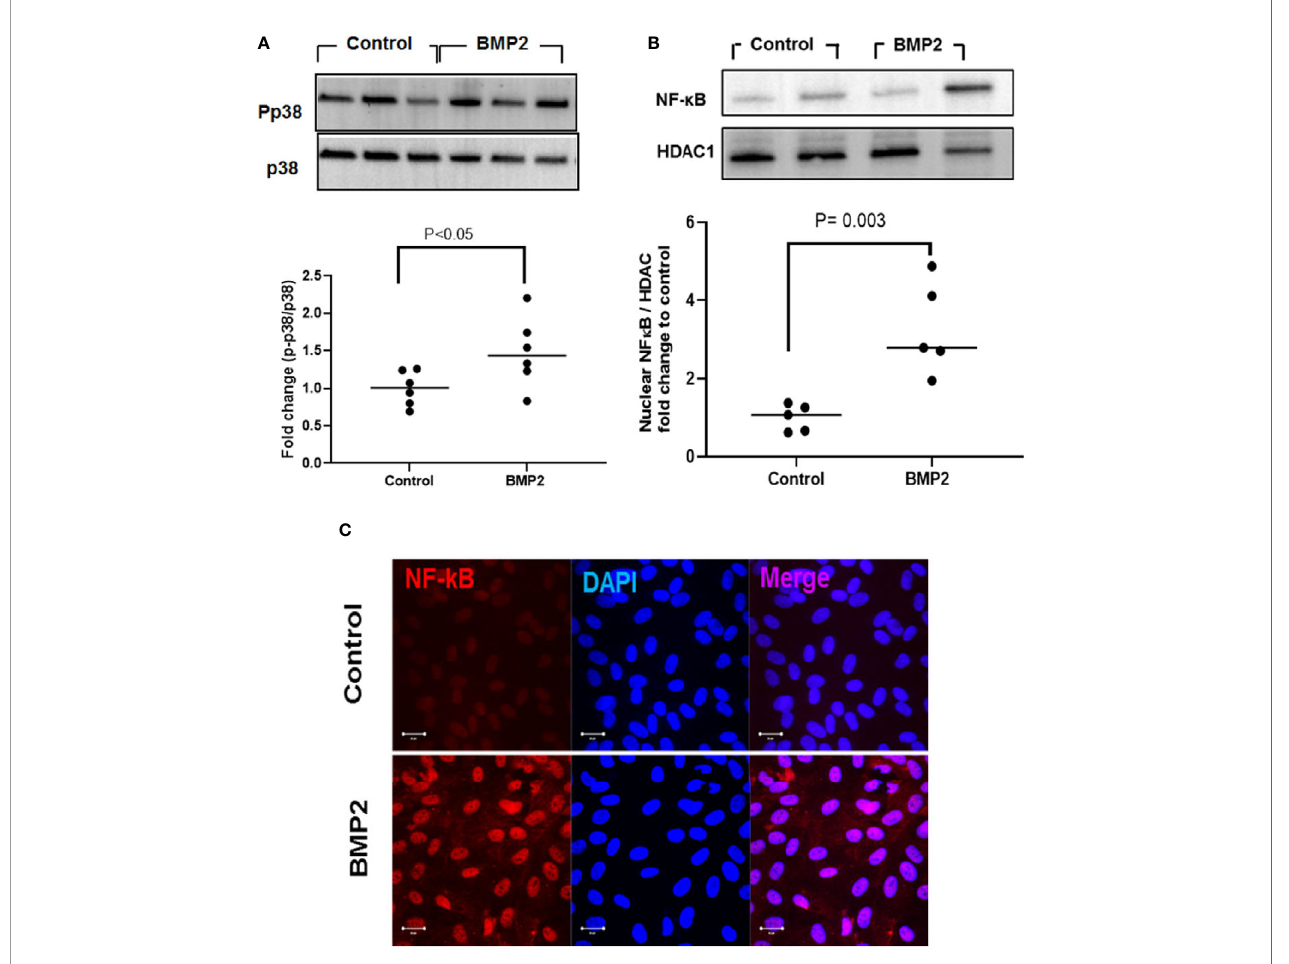
FIGURE 3 | Western blot analysis of the effect of rhBMP2 on p38 and NF k B. Unpaired t-test was used to compare the effect of rhBMP2 on p-p38 and nuclear NF k B compared to control. Densitometry analysis showing signi fi cant increase in the levels of p-p38 and the nuclear NF k B in human retinal endothelial cells (HRECs) compared to the control ( A , B respectively). IF (C) also showing marked increase in the nuclear (blue) immunoreactivity of NF k B (red) in HRECs subjected to rhBMP2 compared to the control. n=5 –